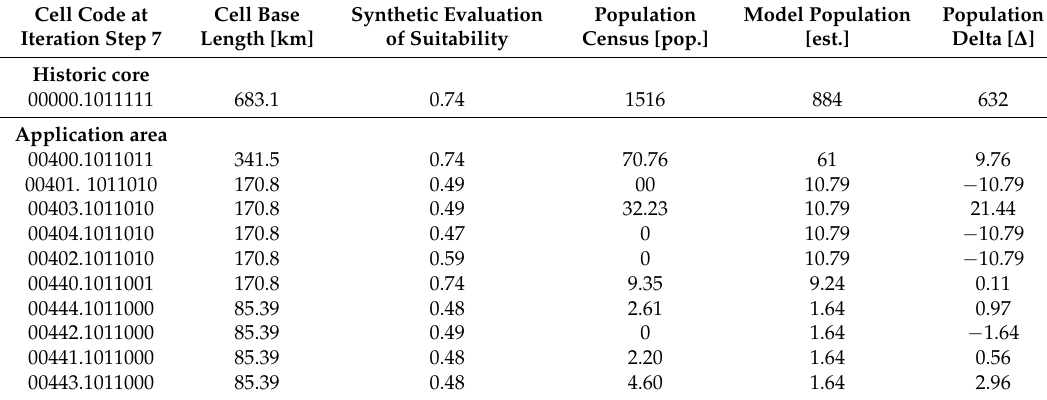
Table 4. Suitability evaluation and comparison between the existing population and the model population. Due to the roughness of governmental data, the existing population numbers are dubious on a local scale for some cells. This shows the common phenomena of a clash between aggregated data and scale. Furthermore, the high impact of the morphological rule can be identified when analyzing the synthetic